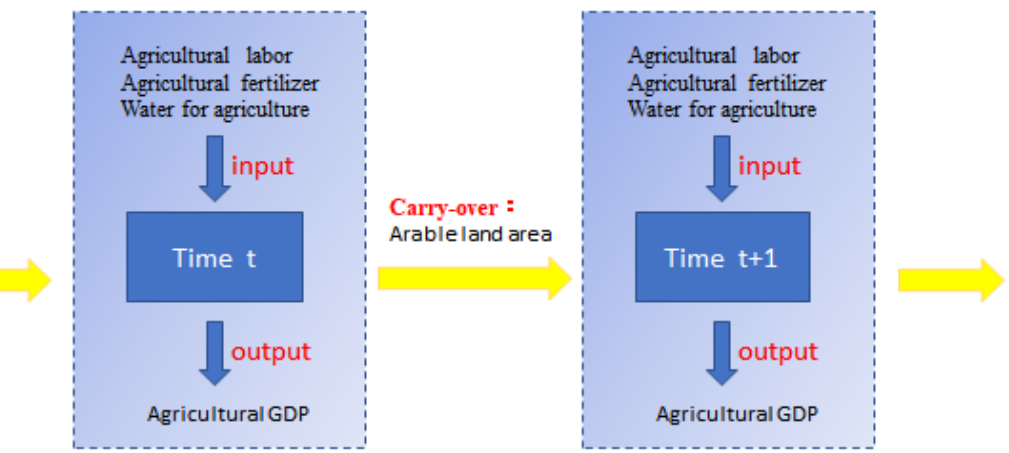
Figure 2. Dynamic SBM basic model of this study.